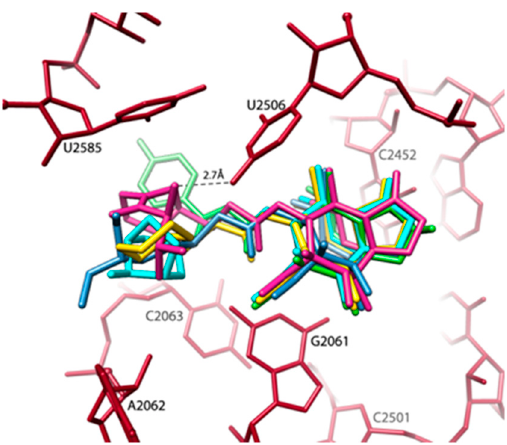
Figure 3. The pleuromutilins binding pocket in SA50S. Color code: SA rRNA-light brown, BC3205-violet, SB571579-green, Retapamulin-cyan, Tiamulin-slate, SB280080-yellow. The pleuromutilins antibiotics are superposed based on the locations of the rRNA of their binding pocket. The critical (additional) H = bond is shown.